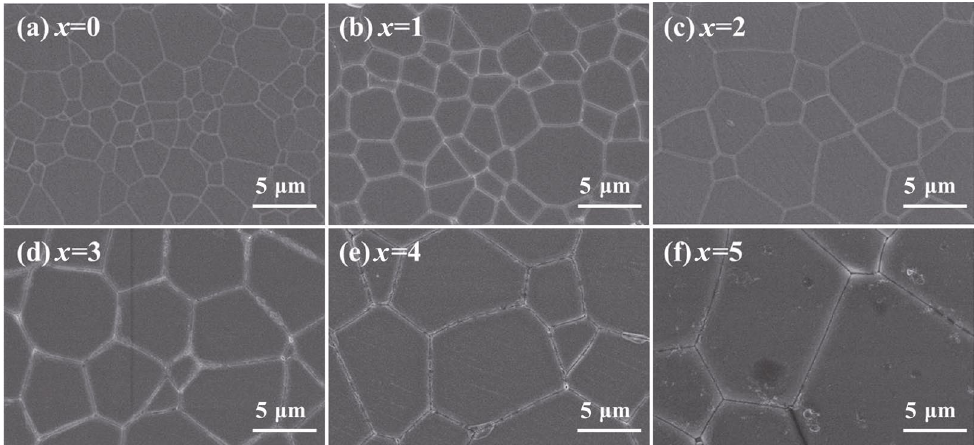
Fig. 5 SEM surface morphologies of Y 3 Al 5– x Ga x O 12 :Ce ( x = 0–5)